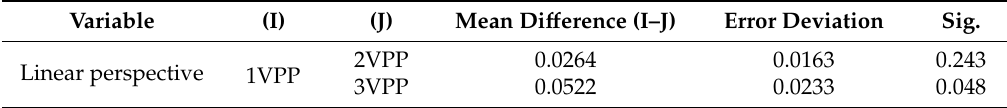
Table 5. Tukey test results (dependent variable: